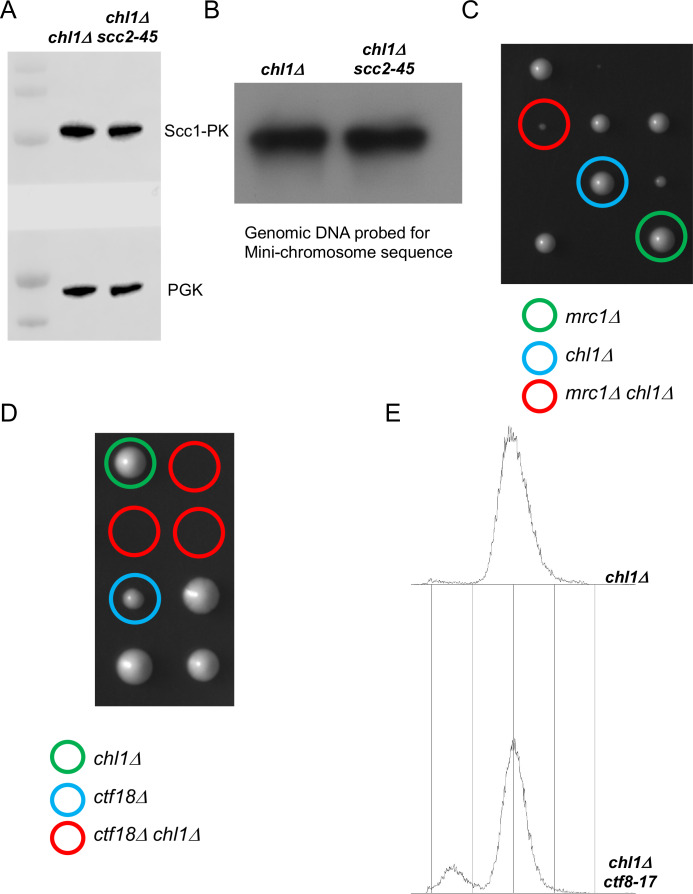
Cohesion can also be established by CTF18-RFC and Scc2 dependent de novo loading of nucleoplasmic cohesin.(A) chl1Δ (K28175) and chl1Δ scc2-45 (K28061) cultures from the final step of the experiment described in Figure 5B were analysed by western botting against the indicated antibodies and in (B), the genomic DNAs from these cultures were analysed by southern blotting against the TRP probe to detect the mini-chromosome. (C) Tetrad analysis of the haploids resulting from a cross of mrc1Δ and chl1Δ strains, the genotypes of selected haploid spores are indicated. (D) Tetrad analysis of the haploids resulting from a cross of chl1Δ and ctf18Δ strains, the genotypes of selected haploid spores are indicated. (E) FACS profiles of the chl1Δ (K28175) and chl1Δ ctf8-17 (K28295) cultures from the end of the experiment described in Figure 5C.